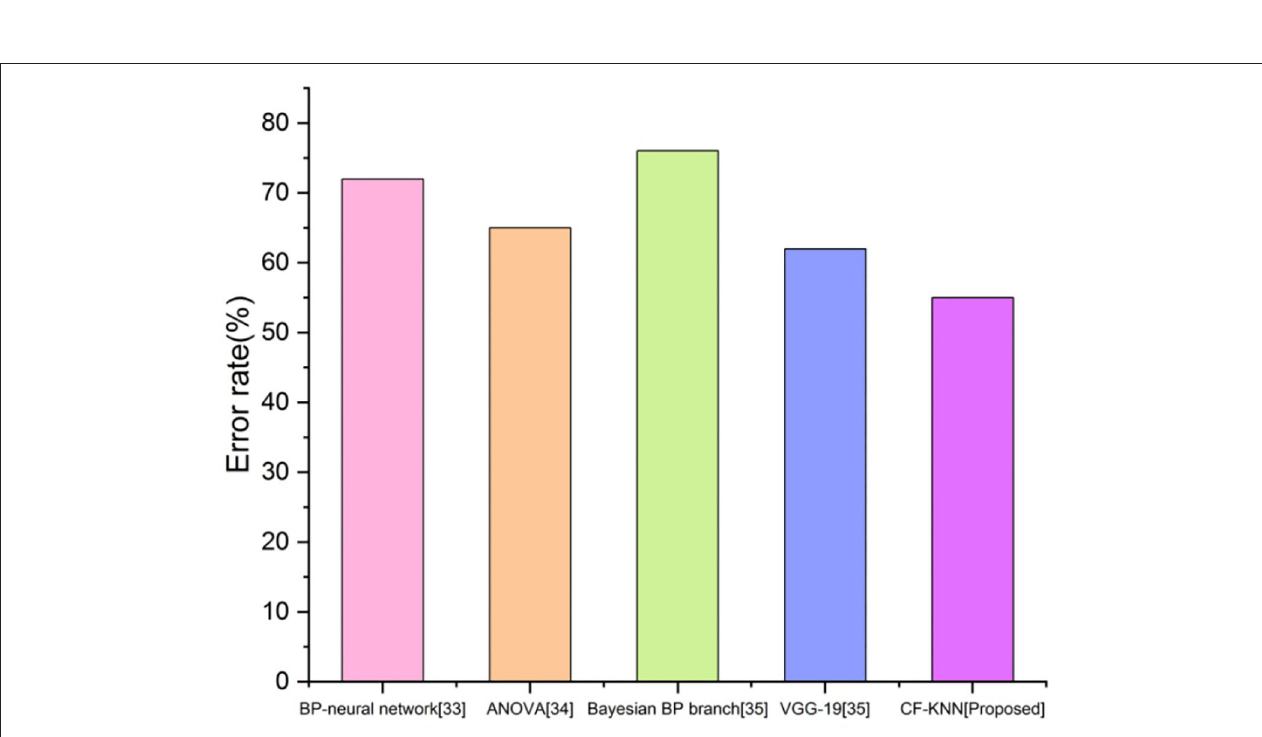
FIGURE 10 | Comparison of error rate with proposed and existing